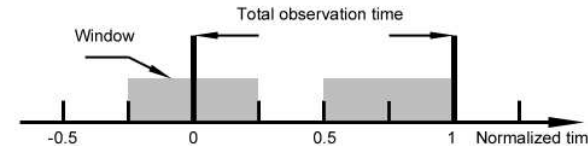
Fig. 5. Temporal window used to compute the distributions in the normalized time